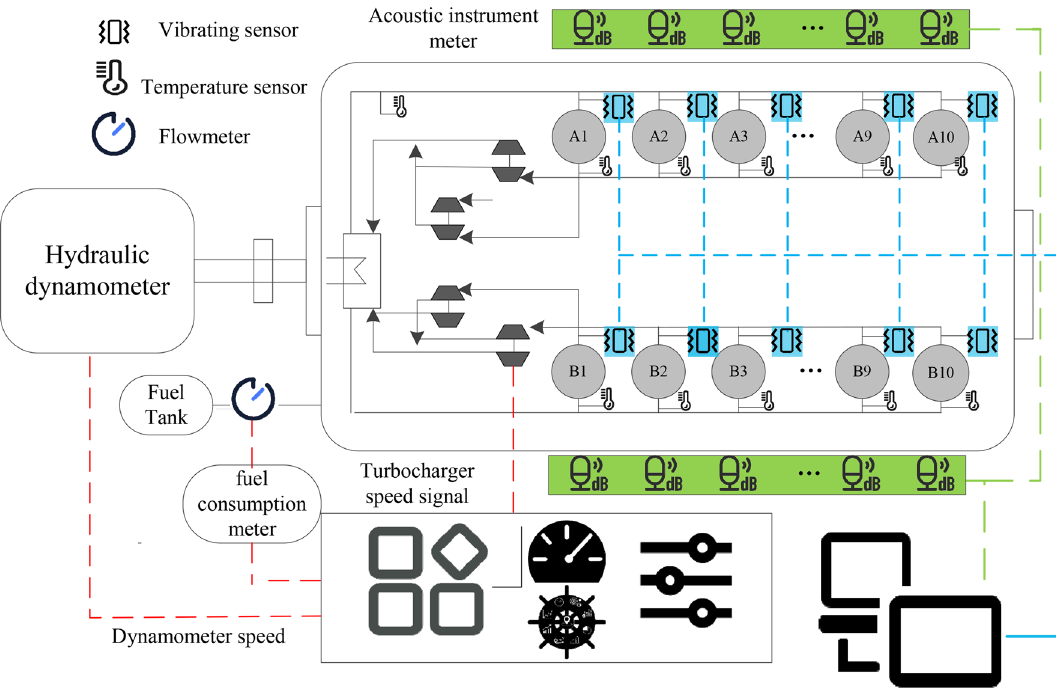
Figure 1. The detailed schematic of the experimental set